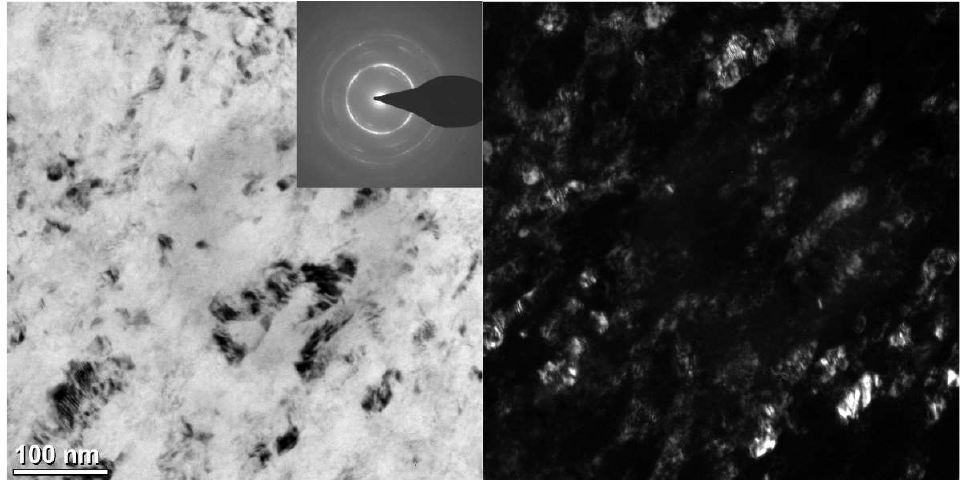
Figure 3. TEM micrographs of the Ti–3.93 wt.% Fe alloy annealed at T = 615 °C, 270 h, quenched and subjected to HPT at 7 GPa, 1 rpm, 5 rot. On the left is a bright field image; on the right is a dark field image of the same area. The selected area electron diffraction (SAED) pattern is shown as inset.